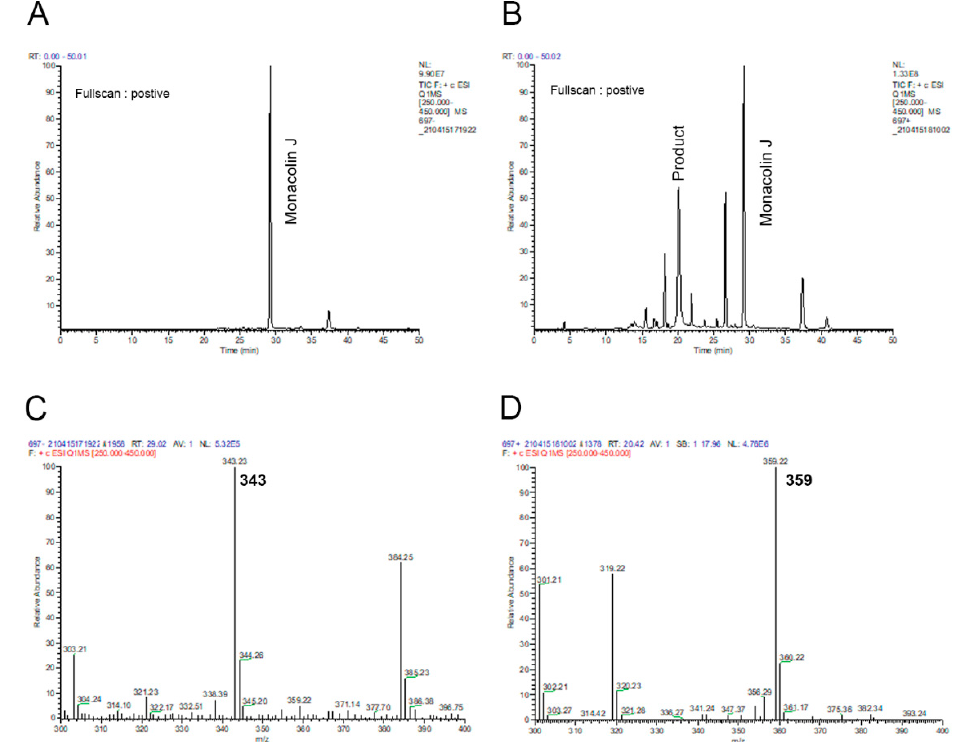
Figure 4. LC–MS results of the product of monacolin J when using CYP102A1. LC–MS chromatogram of monacolin J ( A ) and its reaction mixture catalyzed using CYP102A1 in the presence of NADPH ( B ). The MS spectra demonstrated that the m / z values of the protonated molecular ions of monacolin J ( C ) and its hydroxylated product ( D ) were 343 and 359, respectively.